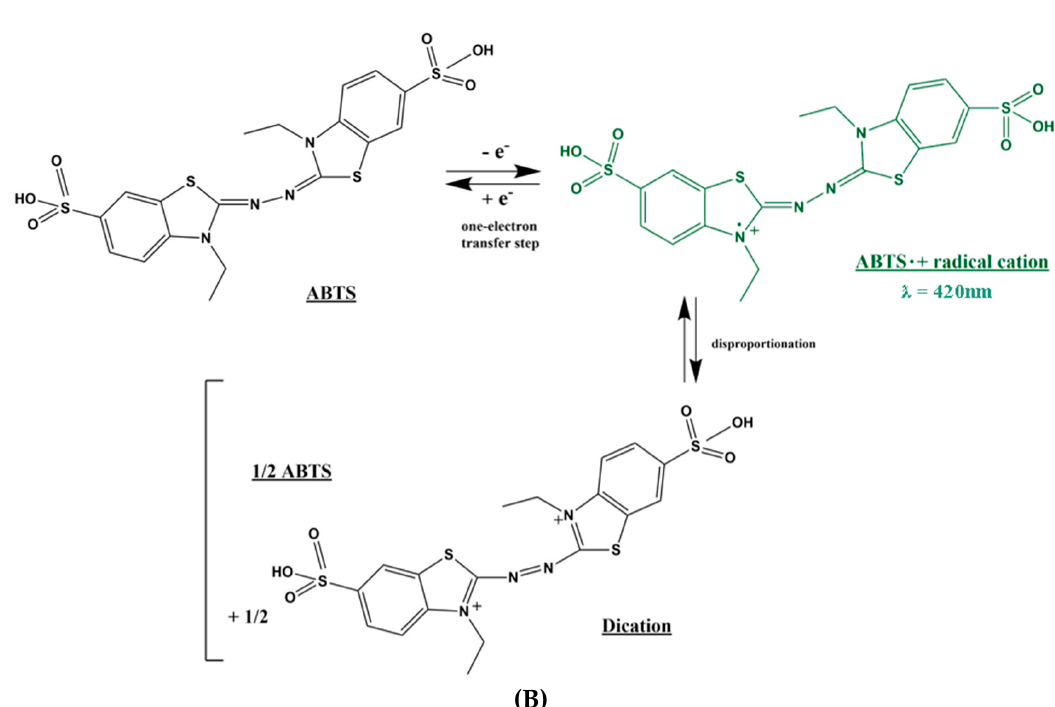
Figure 2. Colorimetric reaction of HRP with the Chromogenic Substrates TMB and ABTS. The colorimetric signal was generated based on the reaction of the enzyme horseradish peroxidase (HRP) with the chromogenic substrates ( A ) 3,3’,5,5’-tetramethylbenzidine (TMB) and ( B ) 2’-azinobis (3-ethylbenzothiazoline-6-sulfonic acid) (ABTS). Sulfuric acid and oxalic acid were used as the stopping solutions for TMB and ABTS respectively [26] .